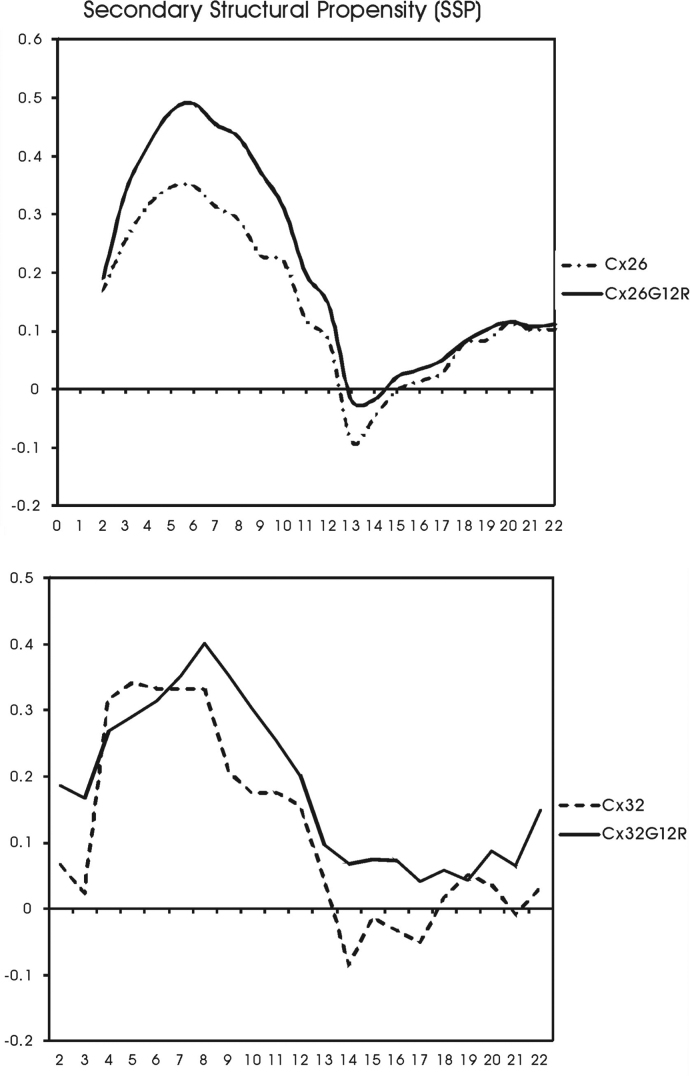
Secondary structure propensity (SSP) scores for Cx26 and Cx26G12R peptides (top) and Cx32 and Cx32G12R peptides (bottom) calculated from 13Cα and 13Cβ chemical shifts.